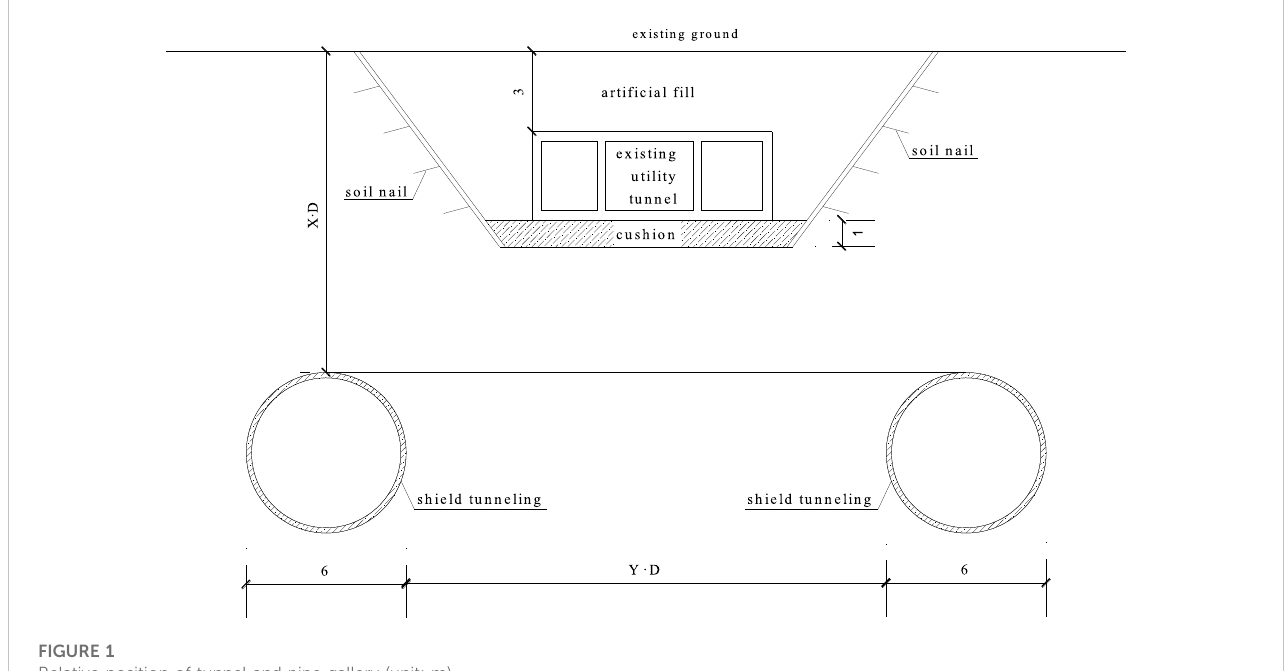
FIGURE 1 Relative position of tunnel and pipe gallery (unit: m).